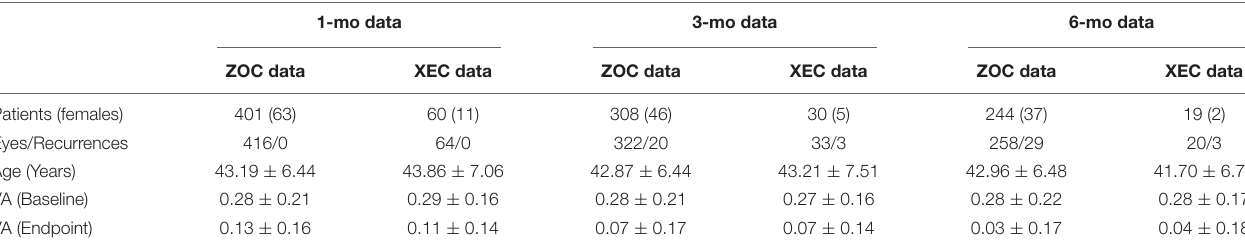
TABLE 1 | Patient